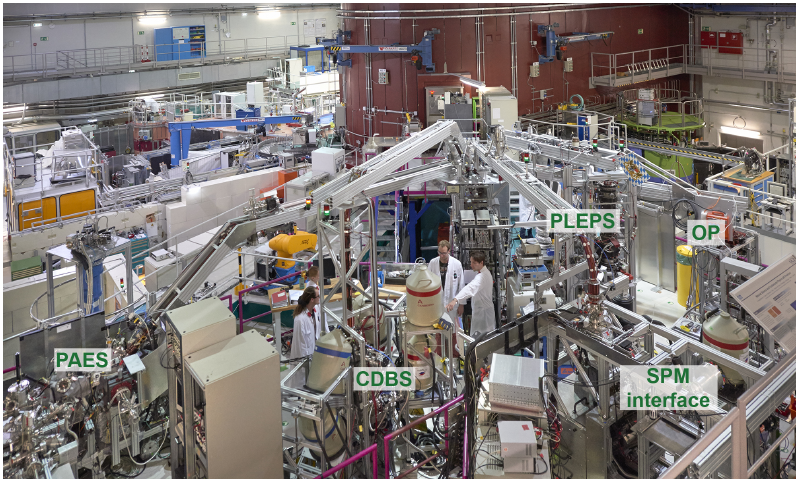
Figure 1: Positron beam facility and instrumentation at NEPOMUC (Copyright by W. Schürmann,